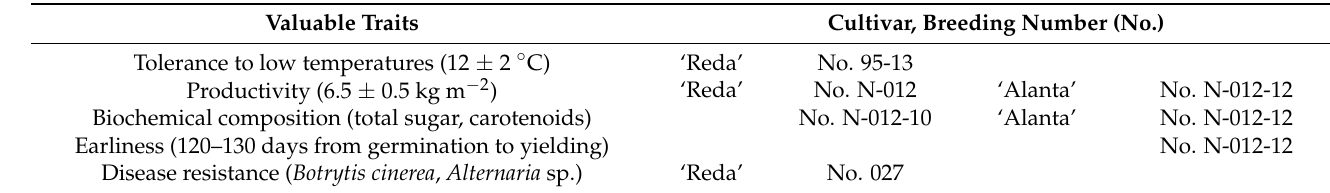
Table 3. Parental material from sweet pepper national and adapted genetic resources. Valuable